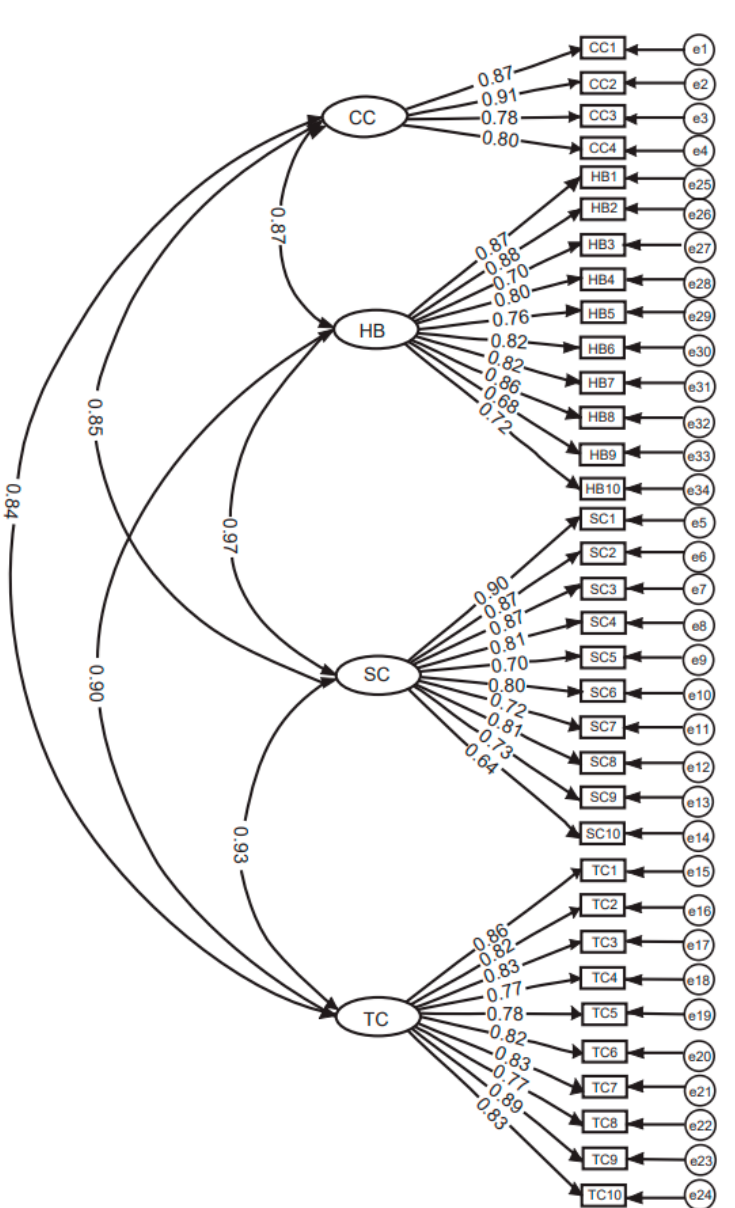
Figure 1. Confirmatory factor analysis of the Team Interactions and Team Creativity scale for Tai- wanese nursing students (TITC-T) demonstrated a 4-factor model with standardized factor loadings: constructive controversy (CC), helping behaviors (HB), spontaneous communication (SC), and team creativity (TC). Note: Residual errors (e) indicated as follows: e1 to e4 for CC; e5 to e14 for SC; e15 to e24 for TC; e25 to e34 for HB; CC1 to CC4 denotes the questionnaire items for CC; HB1 to HB10 denotes the questionnaire items for HB; SC1 to SC10 denotes the questionnaire items for SC; and TC1 to TC10 denotes the questionnaire items for TC.